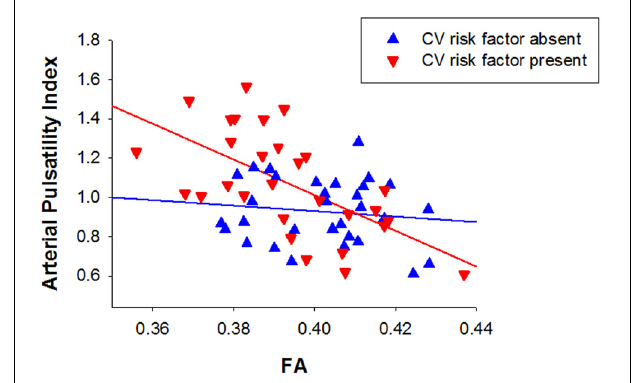
FIGURE 2 | Relationship between arterial pulsatility index and fractional anisotropy for participants with (triangles down) and without cardiovascular risk factors (triangles